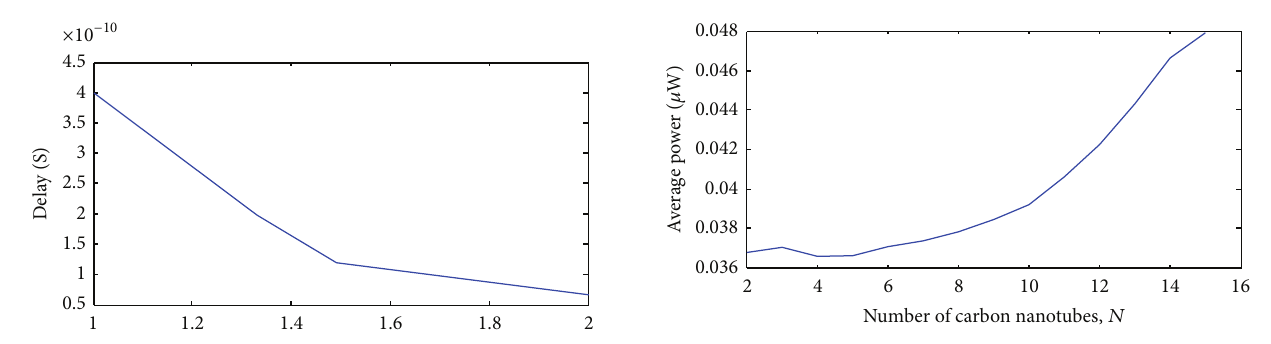
Figure 8: Average power versus number of carbon nanotubes for pure-CNFET inverter.